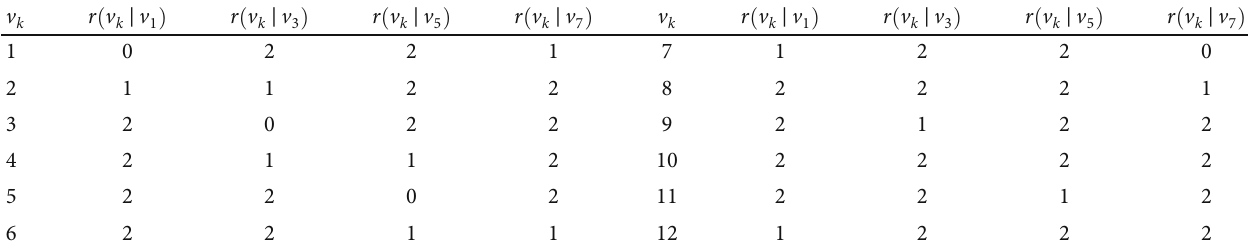
g : = f v , v , v , v 1 3 5 7 a